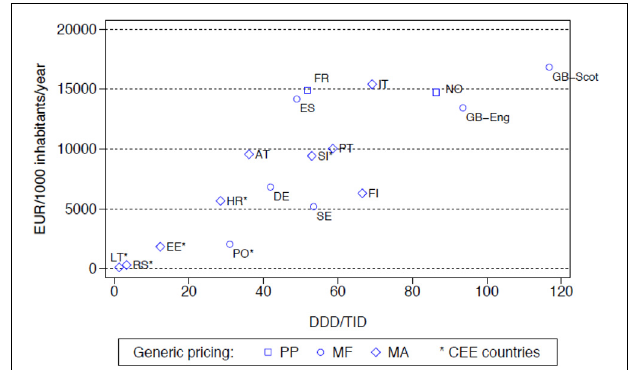
FIGURE 2 | Utilisation (DDD/TID) and overall expenditure (€/1000 inhabitants/year) for the statins among European countries in 2007 (Italy 2008, Serbia 2008) (Godman et al., 2011a). NB: pricing: PP, Prescriptive pricing; MF, Market Forces; MA, Mixed Approach ( Box 1 ). Standard EU country abbreviations have been used. ES =